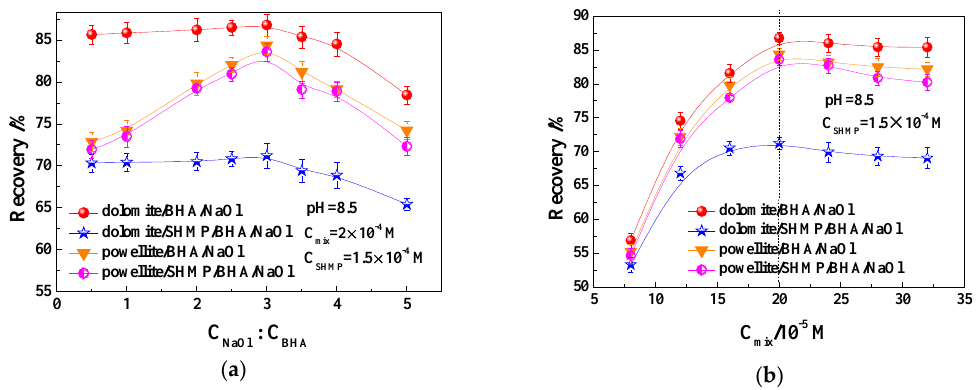
Figure 4. ( a ) Effect of the molar ratio of NaOl/BHA on mineral recovery, and ( b ) the recovery response of minerals to the collector mixture concentration.